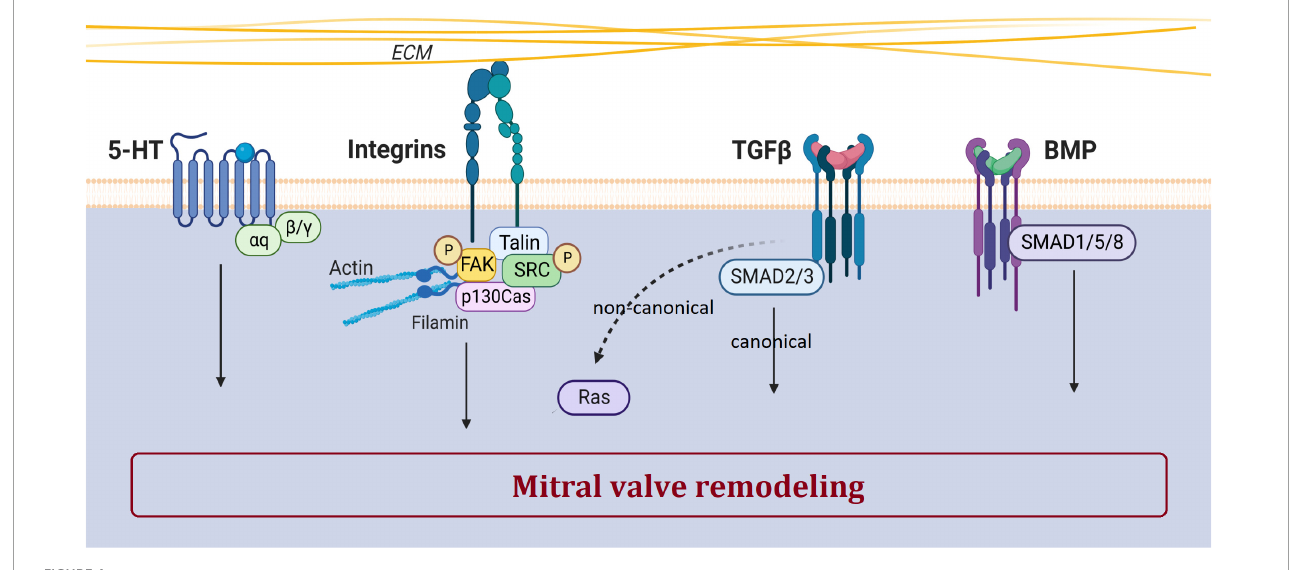
FIGURE4 Main biological pathways involved in MVP. This figure shows the involvement of serotonin, integrin, TGF β , and BMP pathways in the pathogenesis of MVP. The dotted arrow corresponds to the non-canonical TGF β pathway. Created with